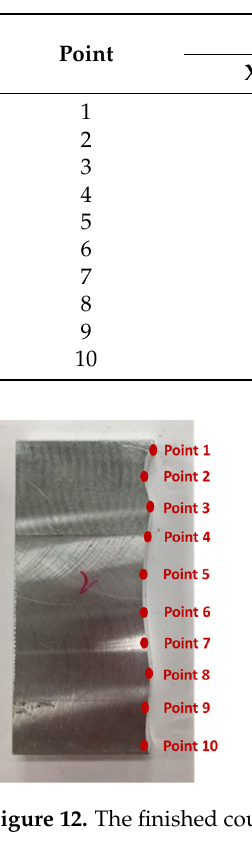
Figure 11. The finished counterpart without compensation. Table 3. The measured coordinates and conversion coordinates of counterpart without compensation.